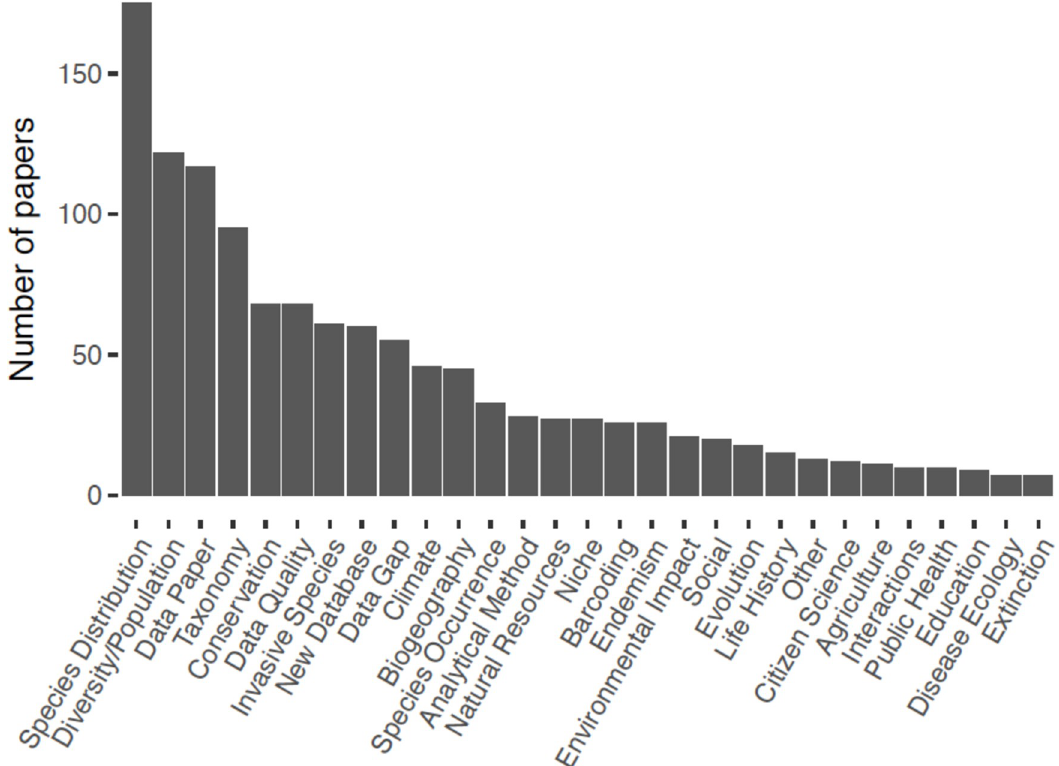
Fig 1. Frequency of major research uses in published papers ( n = 501) that obtain data from species occurrence records available in online databases. See S1 Table for detailed descriptions of each research